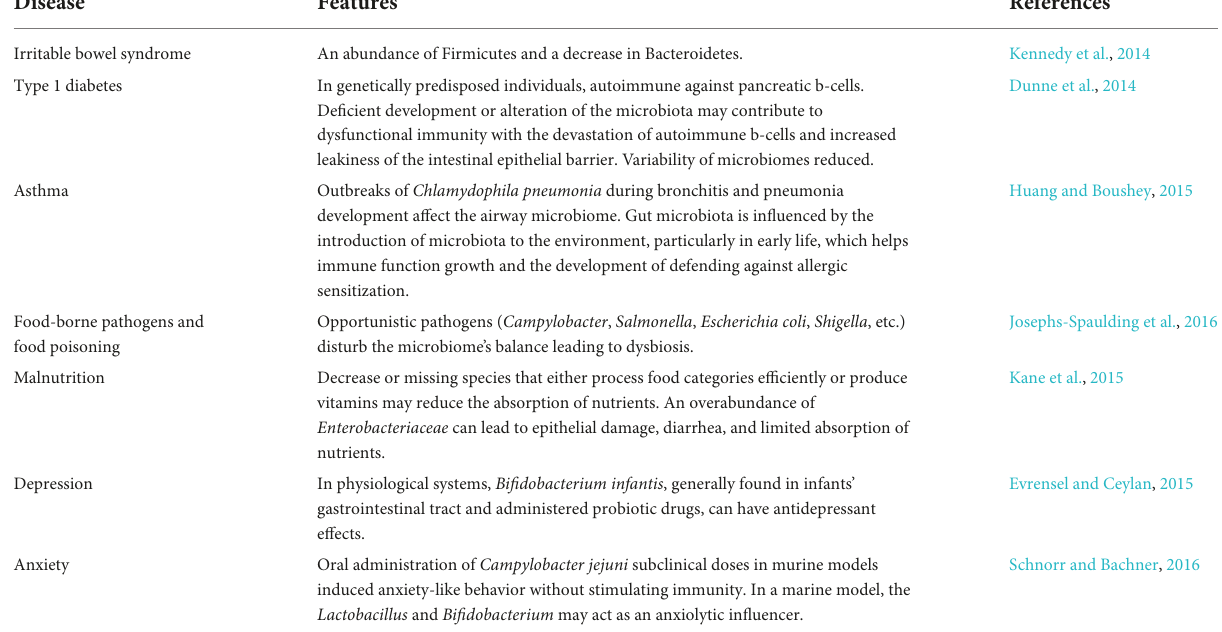
TABLE 2 Diseases associated with gut microbiota